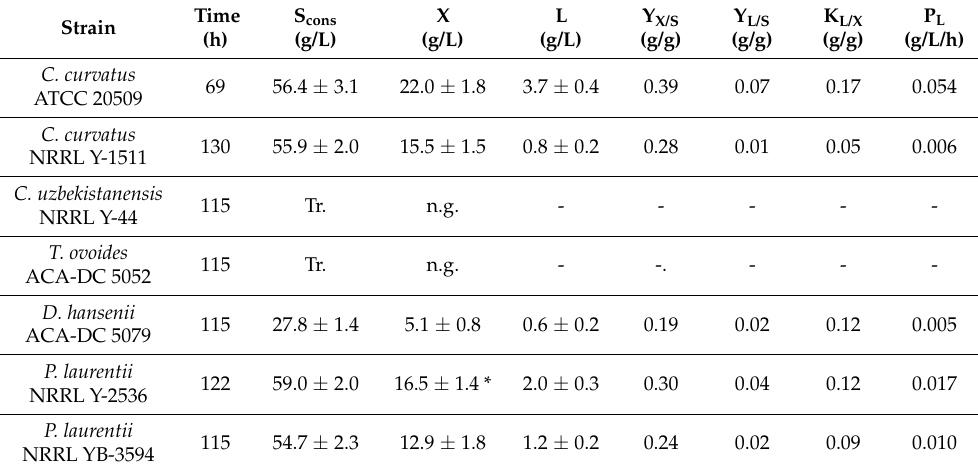
Table 2. Quantitative data originated from kinetics of seven microbial strains, cultivated on a semi- defined medium, with lactose as carbon source, at initial lactose (S0) concentration adjusted to c. 56 g/L and initial molar ratio C/N ≈ 58 moles/moles. Culture conditions as in Section 2; standard error for most experimental points was ≤